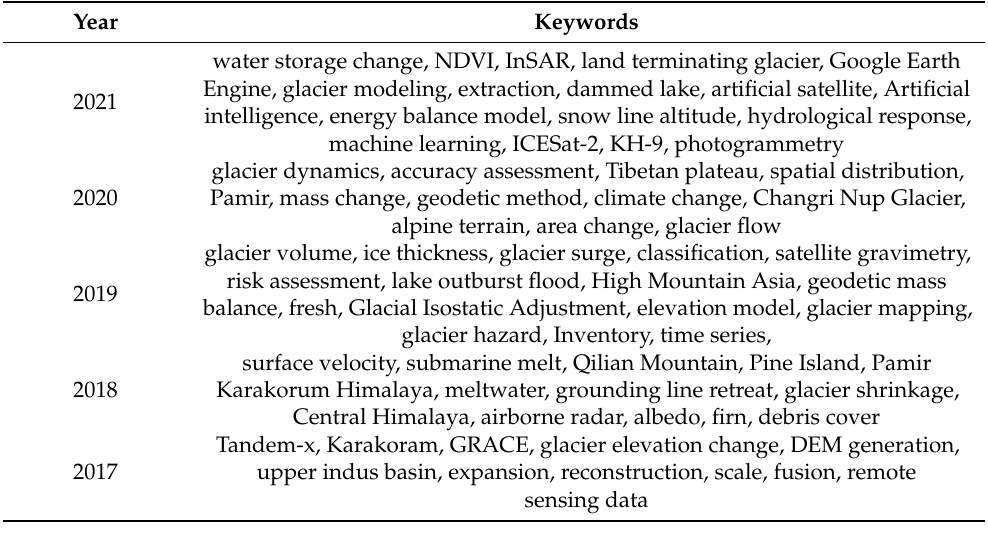
Figure 12. Timeline of research topics. Table 9. High-frequency keywords from 2017 to